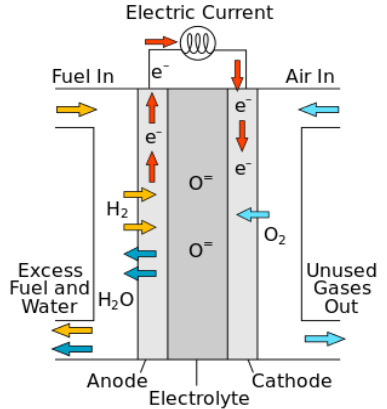
Figure 1. General scheme of a solid oxide fuel cell.